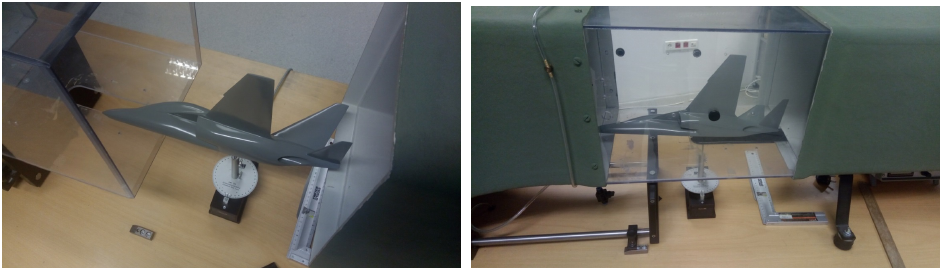
Figure 9. View of the M-346 model mounted in the wind tunnel measurement space before closure and after closure and